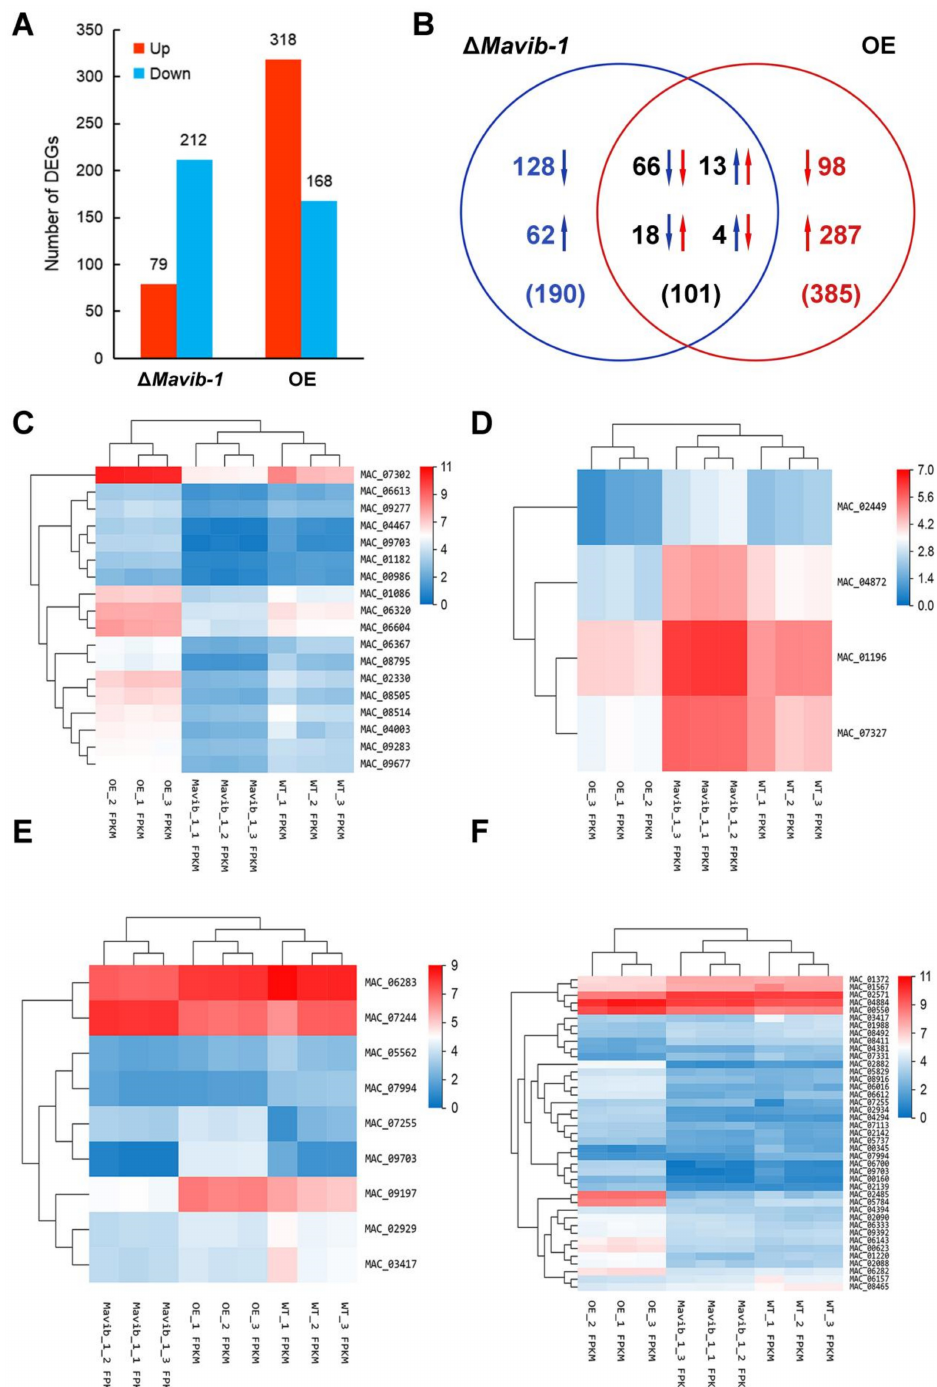
Figure 6. DEGs analysis. ( A ) Statistical histogram of the number of DEGs. ( B ) Venn diagram of DEGs. ( C ) Heat map of 18 DEGs downregulated in ∆ Mavib-1 and upregulated in OE. The 18 DEGs consistent with the change trend of Mavib-1 were analyzed by cluster analysis of expression patterns. The distance calculation method was used: the spearman correlation coefficient between samples, the Pearson correlation coefficient between genes. ( D ) Cluster heat map of the expression levels of the 4 genes upregulated in ∆ Mavib-1 and downregulated in OE. ( E ) Heat map of the expression of DEGs in ∆ Mavib-1 annotated as CAZyme genes. ( F ) Heat map of the expression of DEGs in OE annotated as CAZyme genes. The up and down arrows represent upregulated or downregulated genes, respectively. Numbers in blue represent ∆ Mavib-1 and red represent OE. The red color denotes the upregulated DEGs, and the blue color denotes downregulated DEGs. The log 2 (expression value + 1) of the sample were shown in the horizontal axis, and DEGs are shown at the right-hand vertical